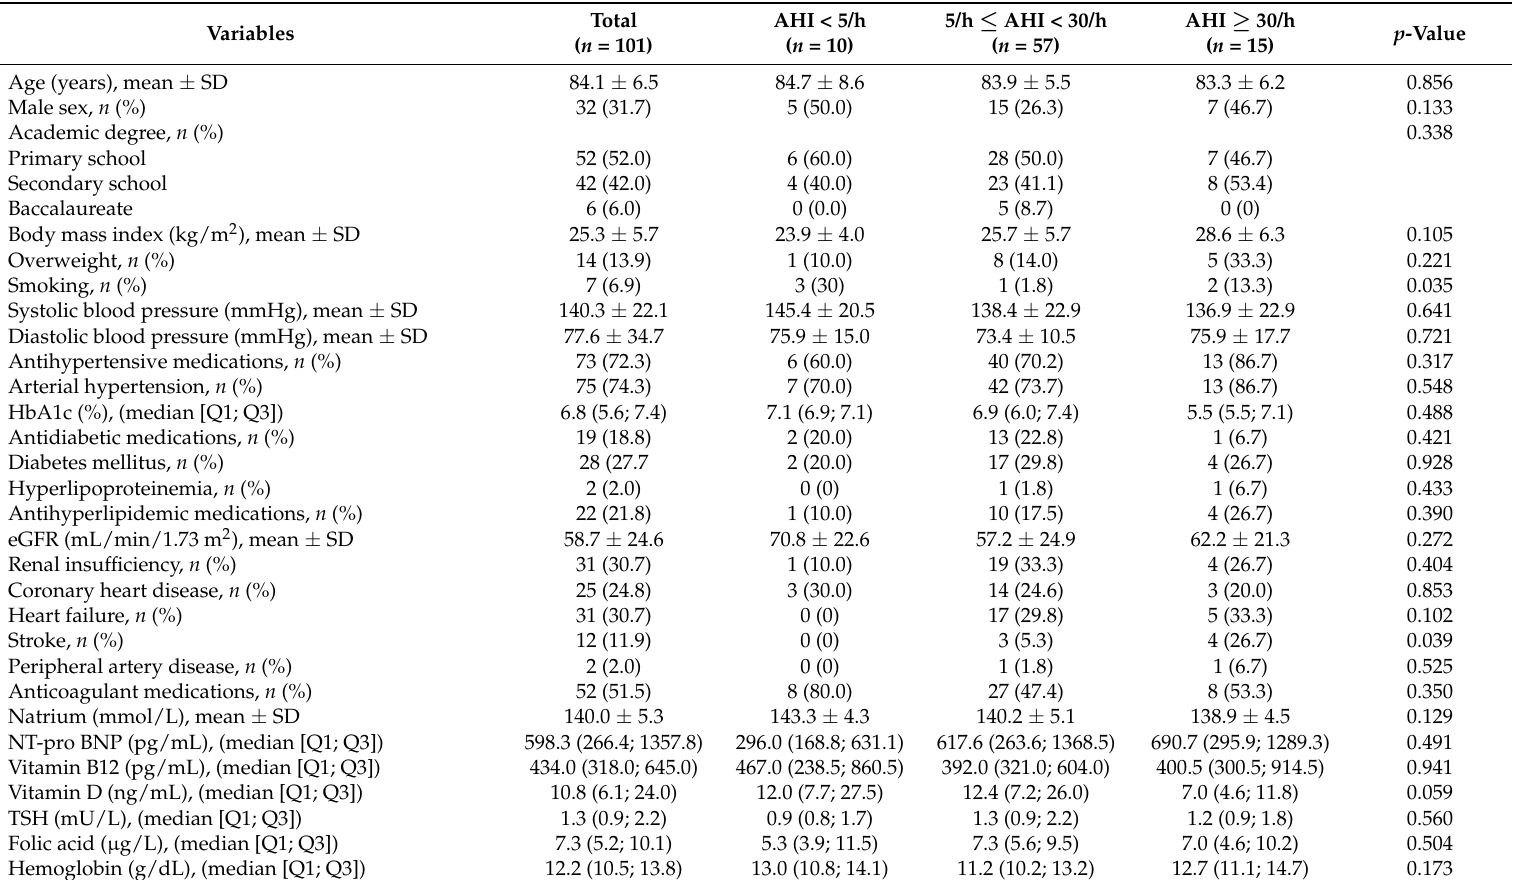
Table A1. Demographic and clinical characteristics of the study cohort also split by alternative AHI